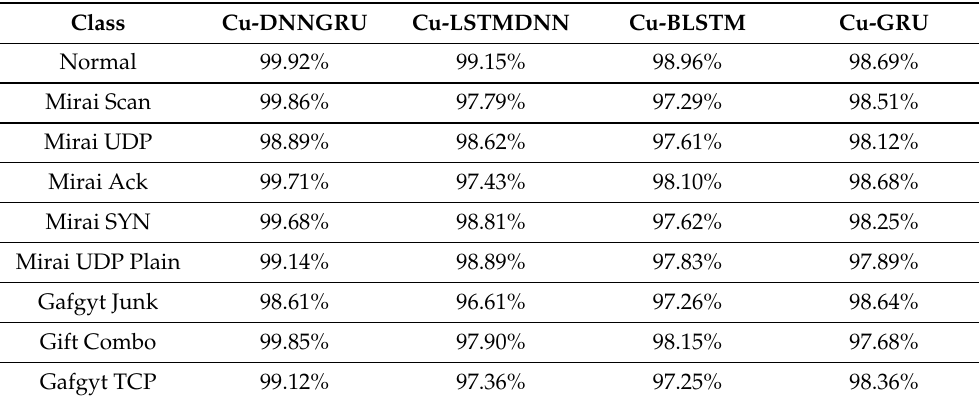
Table 5. Class-wise detection